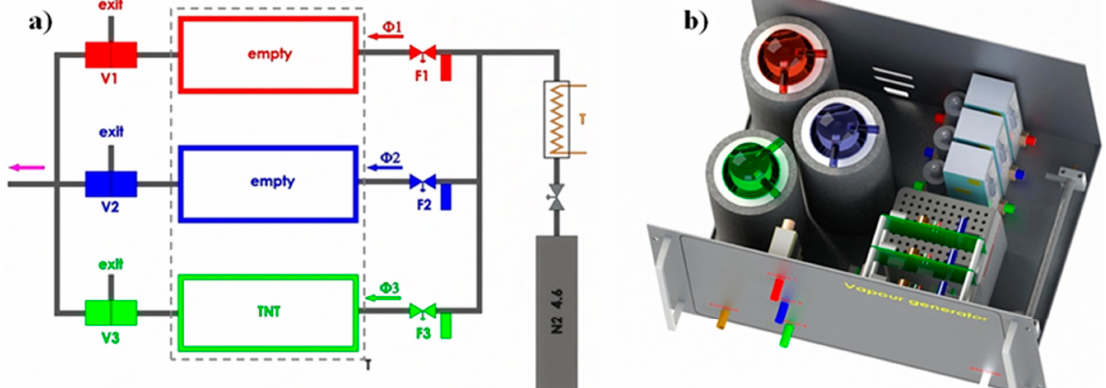
Figure 11. ( a ) Schematic diagram of the vapour generator used for TNT, RDX, DNT and H 2 O measurements. N 2 gasfrom a storage tank is thermally stabilized (T) and divided into three parallel flow lines ( Φ 1, Φ 2, Φ 3), each with electronic flow regulator (F1, F2, F3). The switching between the pure carrier gas and gas with the known concentration of the explosive’s vapour, while keeping the total mass flow constant, is done by mixing the gas from an empty glass cylinder ( Φ 1) with either pure gas ( Φ 2) or with saturated gas ( Φ 3). Three valves V1, V2 and V3 control the mixing. ( b ) A model of the actual vapour generator used in the experiments. Red, blue, and green colours represent individual flow lines.